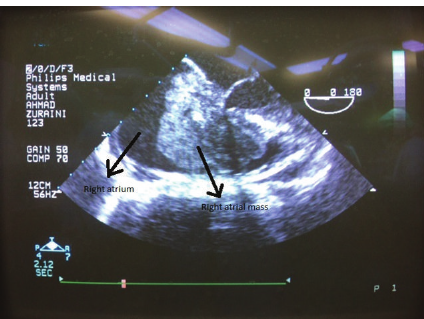
Figure 1: Intraop. transechocardiograph shows right atrial mass attached to interatrial septum.